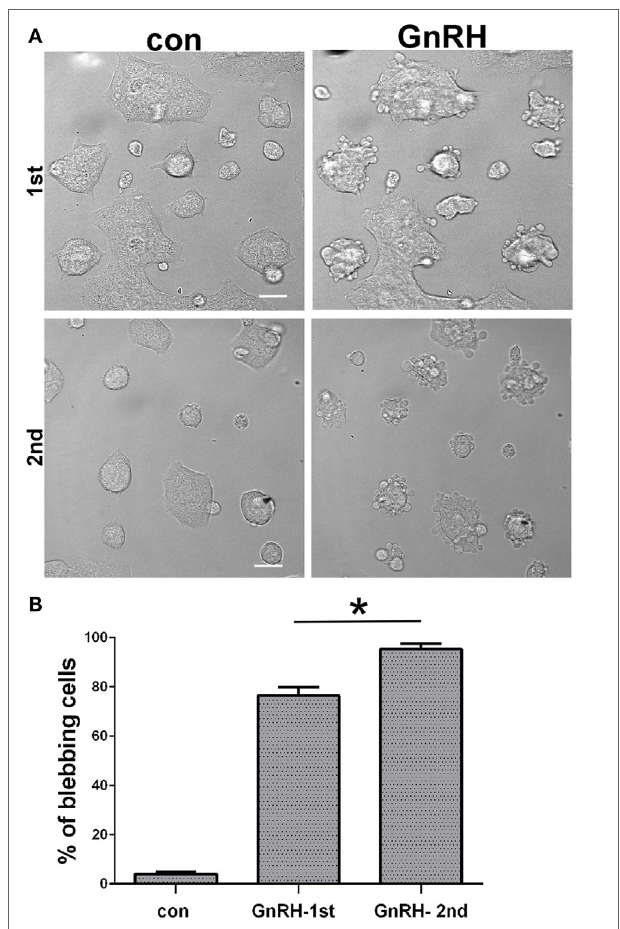
FigUre 2 | Priming effect of gnrh upon blebs formation . (a) Serum-starved L β T2 cells were incubated for 30 min with 10 nM GnRH and analyzed for blebs formation as above. Another group of cells were first incubated for 30 min with 10 nM GnRH, at the end of which GnRH was removed by a wash. Six hours later, a second dose of 10 nM of GnRH was added to the cells. Both groups of cells were imaged using confocal microscopy. The scale bar is 20 µm. (B) Quantitation of blebbing cells in control, GnRH (first treatment) and GnRH (second treatment). Images of at least 10 fields were taken for each treatment, and the bars are mean ± SEM. * p -Value ≤ 0.05 vs. GnRH first